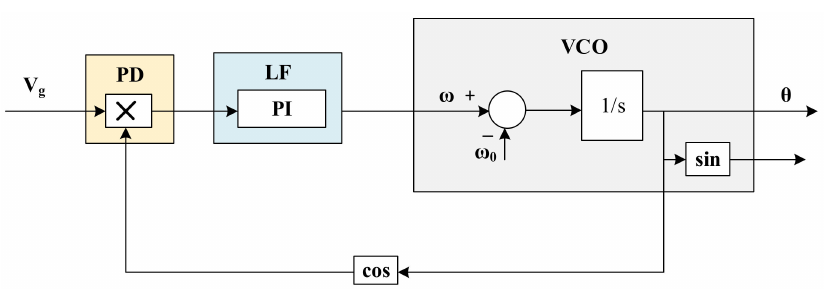
Figure 14. A typical model of single-phase